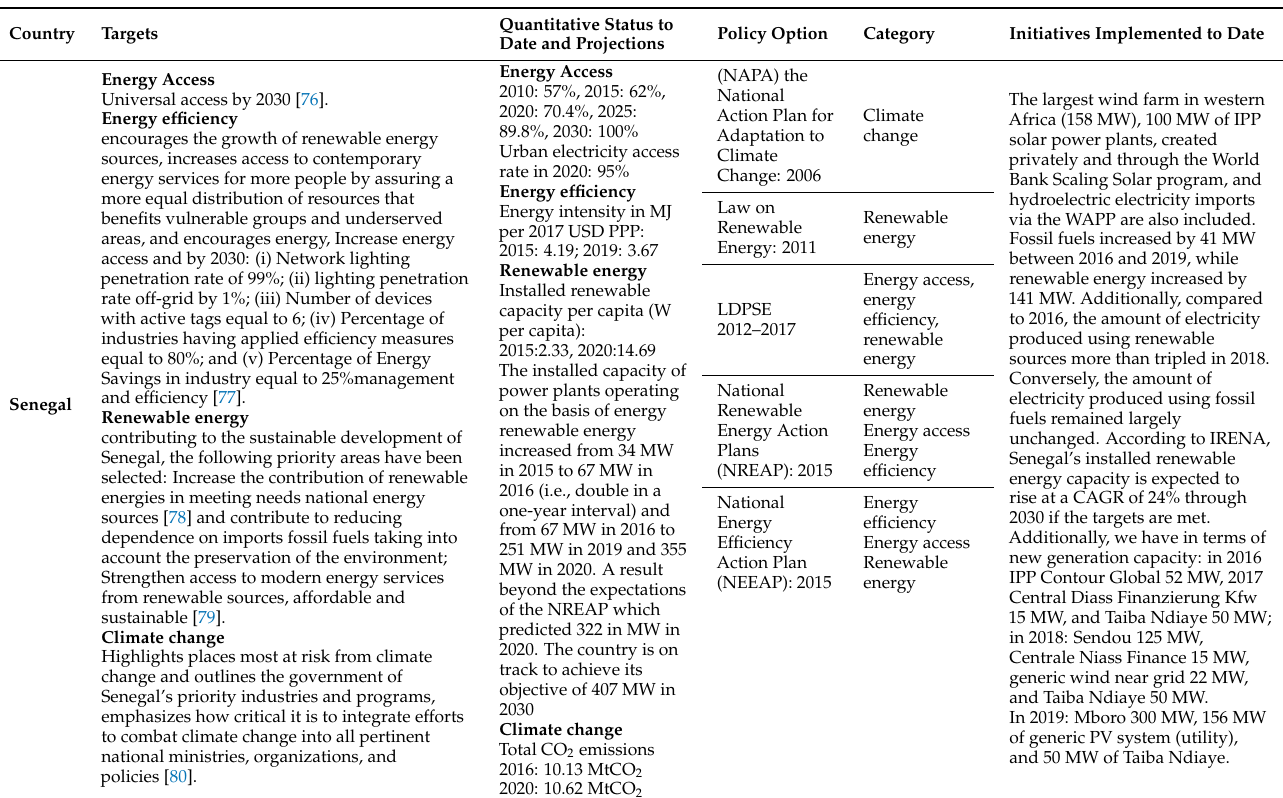
Table 13. Senegal (data from [22–24]).